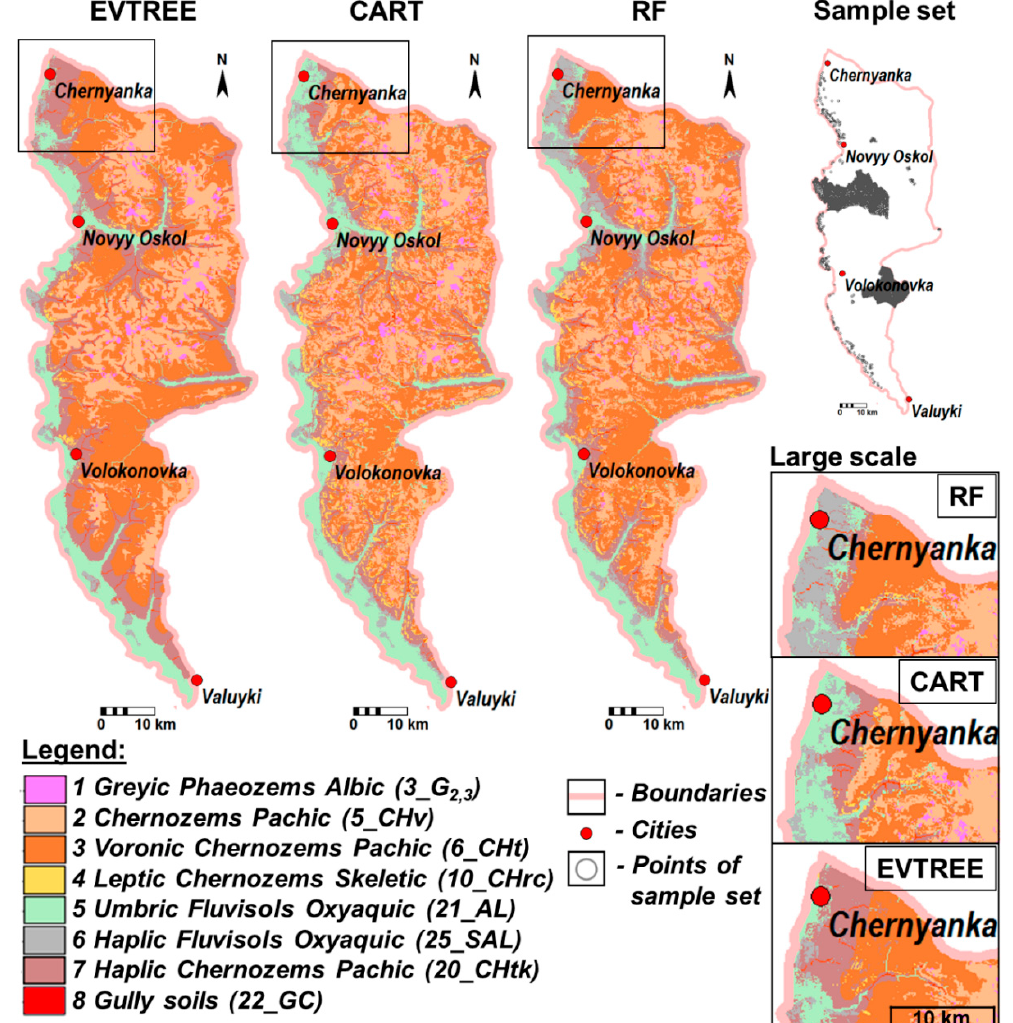
Figure 7. Sample set and soil maps that were created using the three methods: EVTREE, CART, and Random Forest.